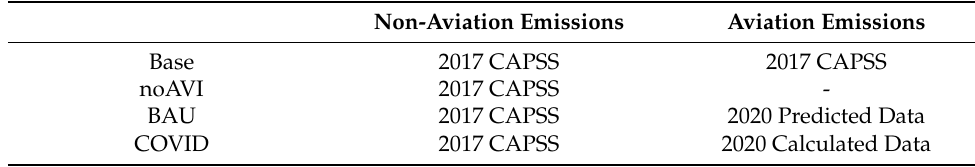
Table 1. Input emissions data for each